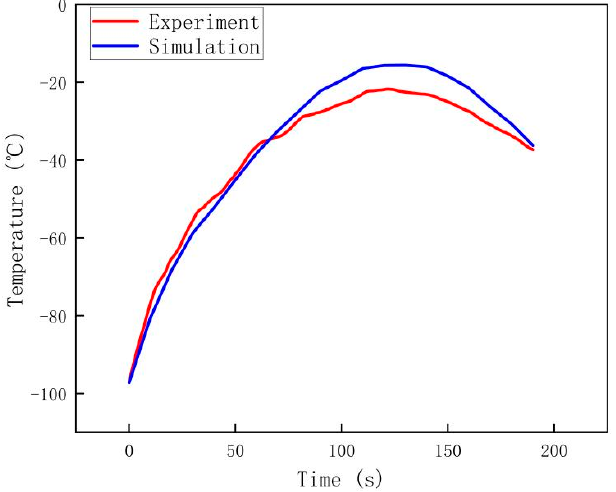
Figure 10. Drill bit temperature curve for No. A2 in experiment and simulation.